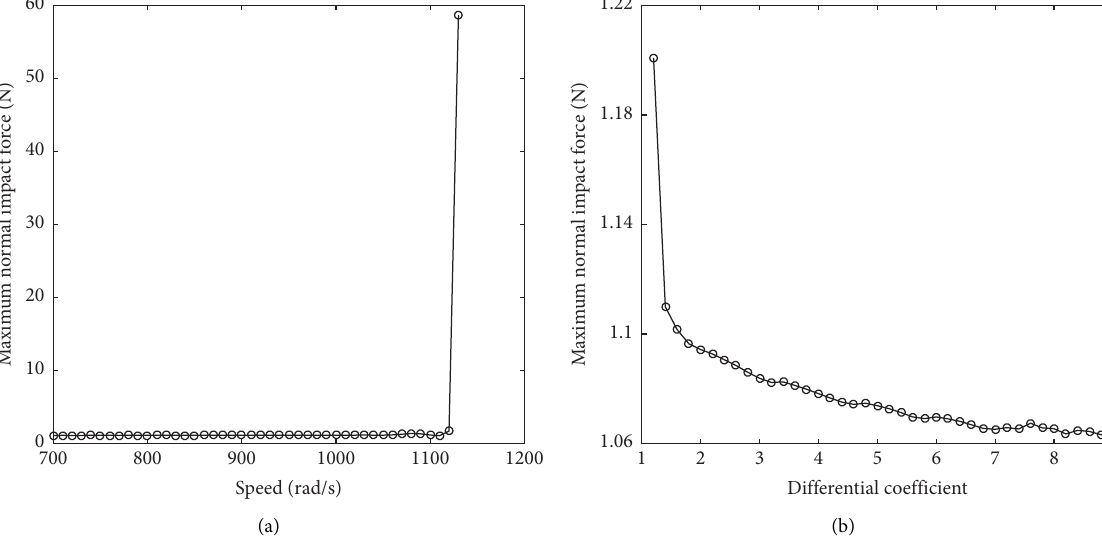
� 10 and r � 1.2. (a) K � 1.2. (b) ω � 700rad/s. p s d i